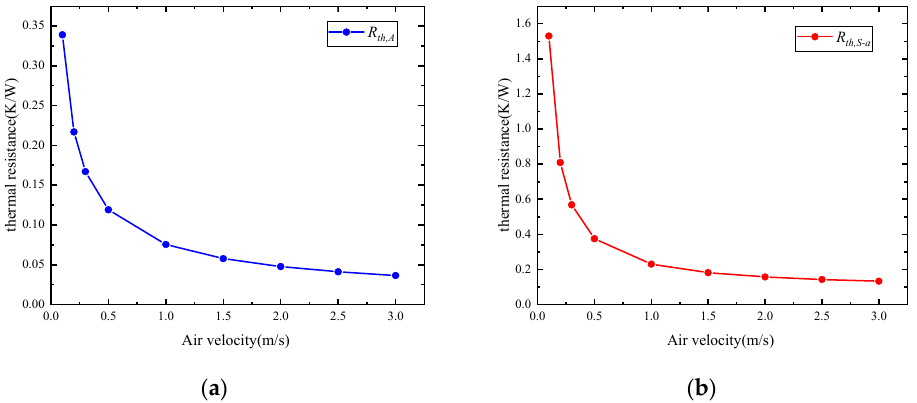
Figure 10. The changes in thermal resistance with different air velocity. ( a ) Comparison of the R th,A with different air velocity; ( b ) Comparison of the R th,S − a with different air velocity.